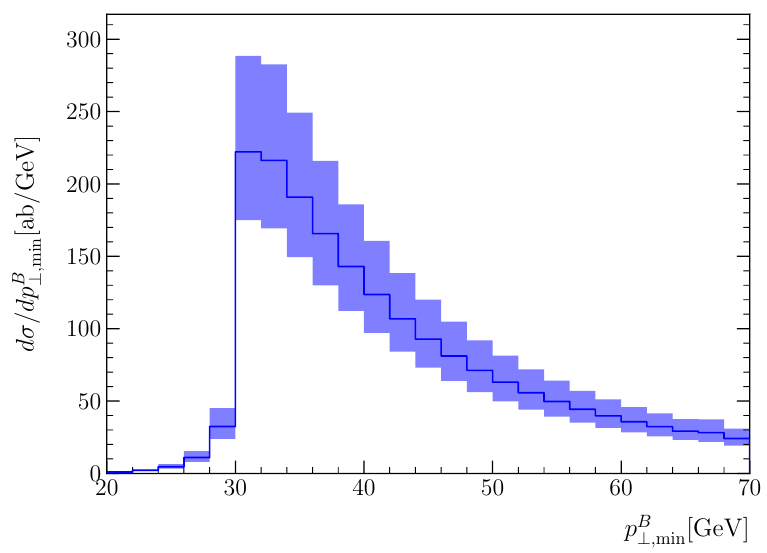
Figure 1. The distribution of the minimum transverse momentum of jets used in the matching, p B , for Higgs boson plus dijet production of transverse momenta larger than 30 GeV. The fact ? ; min that the distribution falls o(cid:11) quickly below the jet analysis scale ensures the resummation phase space with a given minimum jet transverse momentum is covered by a (cid:12)xed-order generation with a slightly smaller requirement on the jet transverse momentum. For example, a generation of (cid:12)xed-order events with a minimum jet transverse momentum of 20 GeV is su(cid:14)cient for an analysis requiring a transverse momentum of at least 30